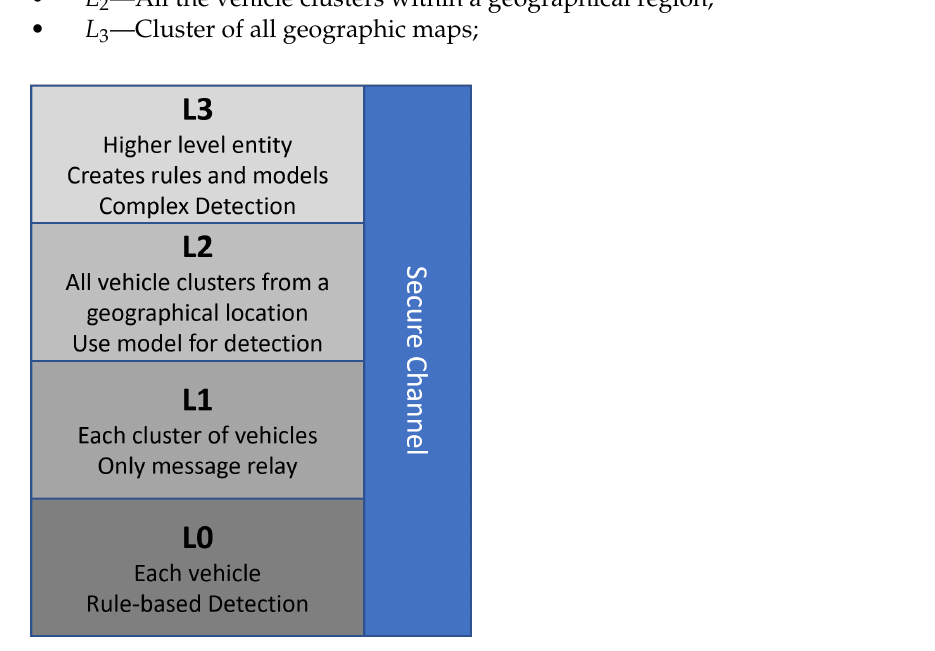
Figure 2. Intelligent Hierarchical IDS Security Framework Functional